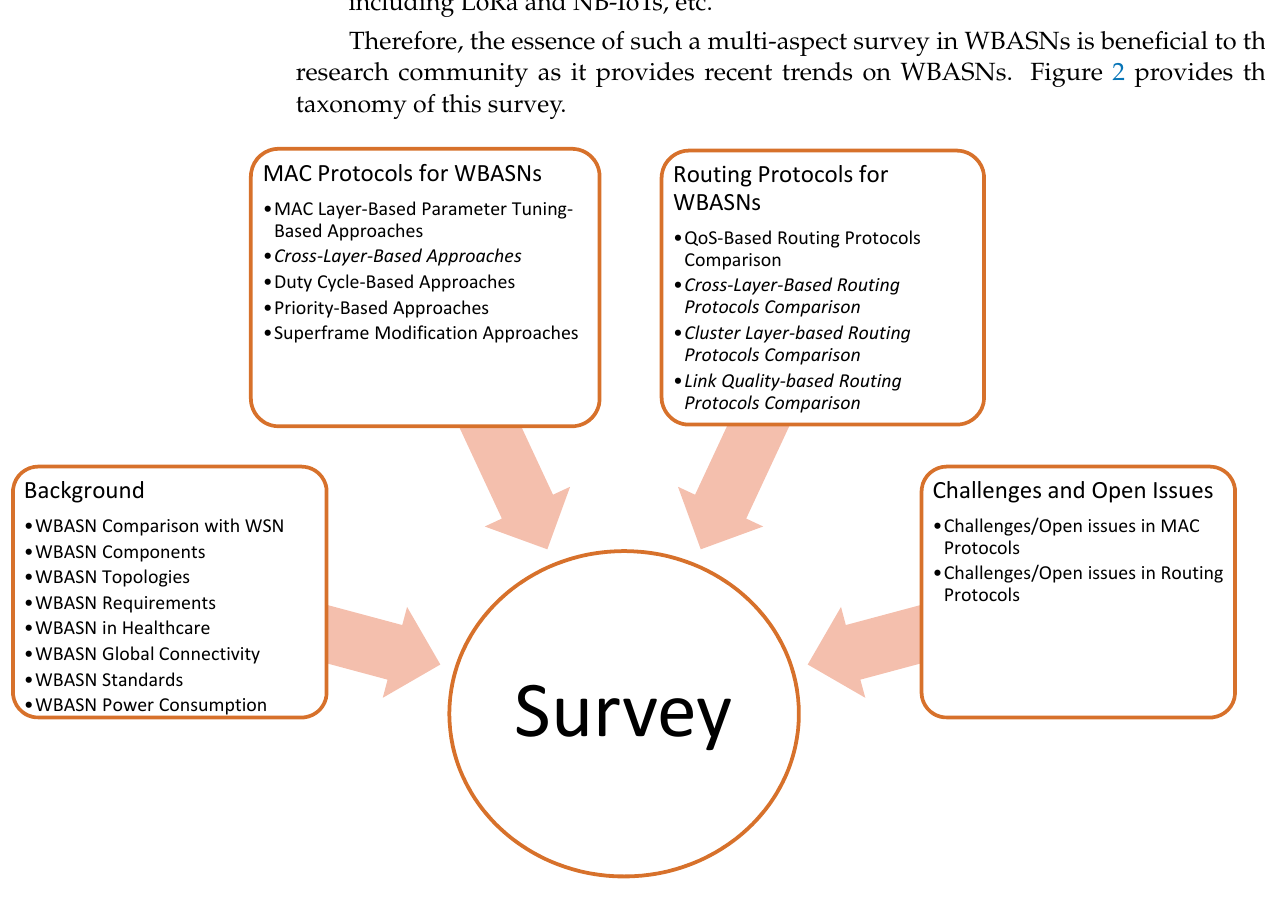
Figure 2. Taxonomy of this survey.